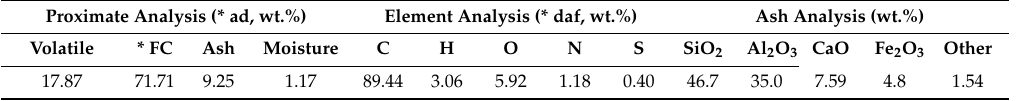
Table 1. Properties of the coal fines.